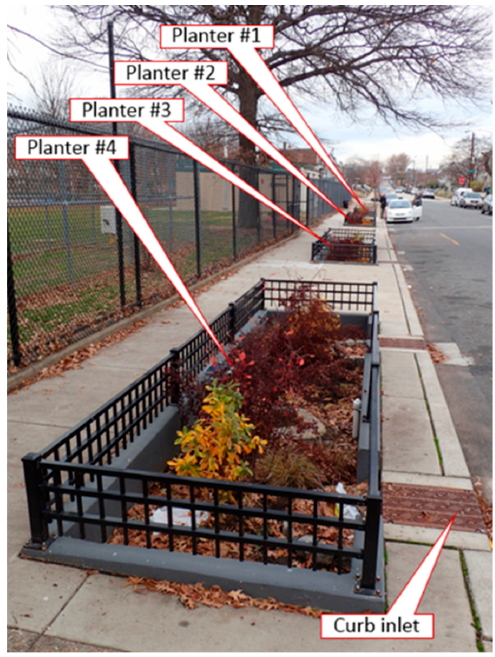
Figure 1. Green infrastructure sidewalk planters under investigation (reprinted from Tu and Traver [22] with permission from ASCE).